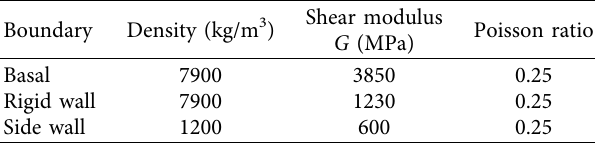
Figure 3: Impact of debris flow on rigid wall: (a) continuous phase and (b) slope pileup phase. Table 1: Boundary material